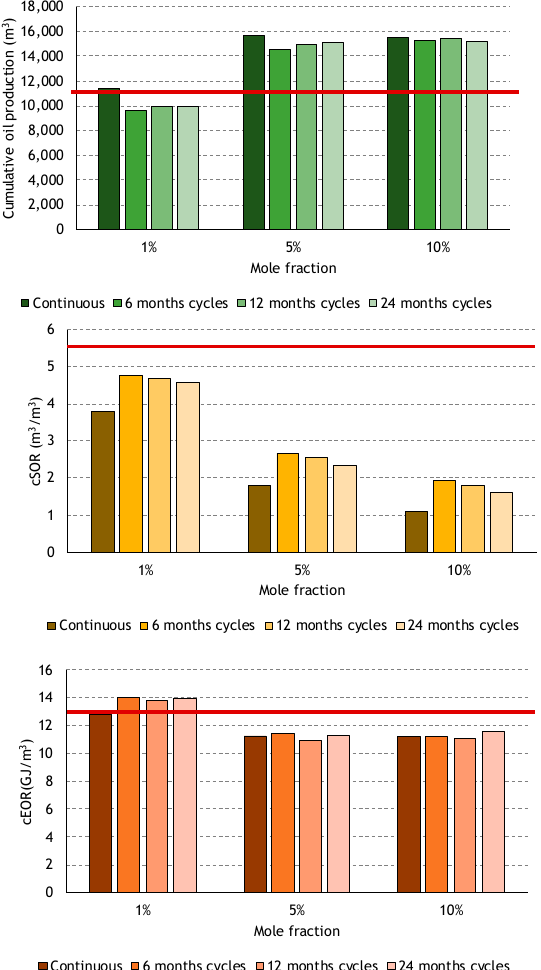
Figure 8. Cumulative oil production, steam-to-oil ratio (cSOR), and energy-to-oil ratio (cEOR) for SAGD and ES-SAGD cases with different solvents and concentration. SAGD results are indicated with a horizontal red line.